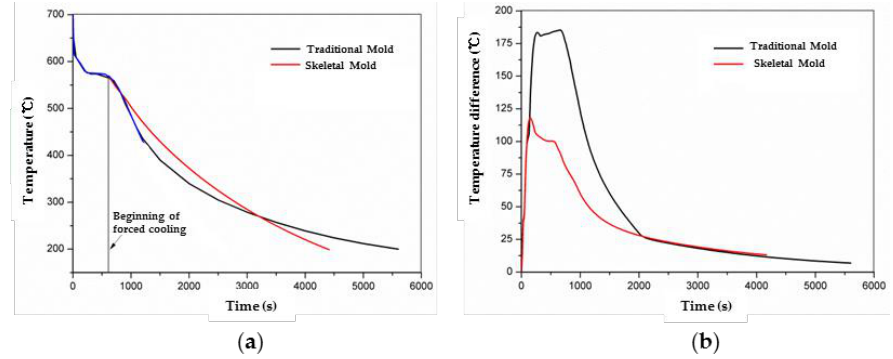
Figure 9. Comparison of cooling curves of castings in the skeletal and traditional molds: (a) cooling curves and (b) temperature difference of thick and thin bars